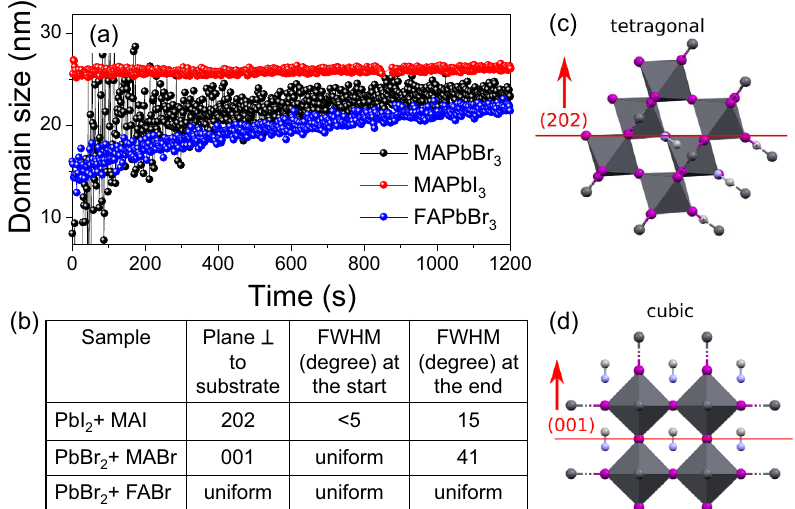
Fig. 3 Growth and crystallographic orientation of perovskite grains. a Crystal domain size estimated by the radial peak width (FWHM) as a function of reaction time and the domain size growth of iodide perovskite is quite rapid and the resolution limit is reached within seconds. b Table summarizing preferred orientation and angular distribution, and preferred orientation of c MAPbI 3 and d MAPbBr 3 grains with respect to the plane of the substrate. The preferred orientation of perovskite crystallites during the real-time experiment was determined by investigating the angular intensity distribution for the respective Bragg re fl